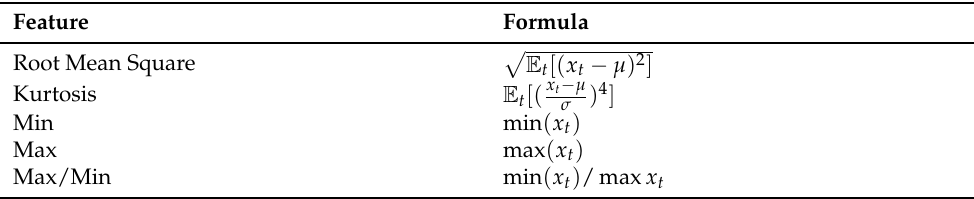
Table 4. Time series features used in the simple MLP approach. The features are computed separately for each accelerometer